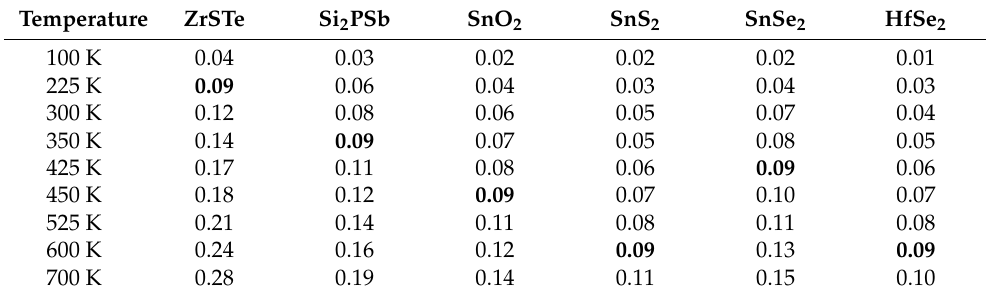
Table 3. The summary of δ values at different temperatures for several Janus monolayers and similar structures, where δ = 0.09 are shown in bold. Temperature ZrSTe Si 2 PSb SnO 2 SnS 2 SnSe 2 HfSe 2 100 K 0.04 0.03 0.02 0.02 0.02